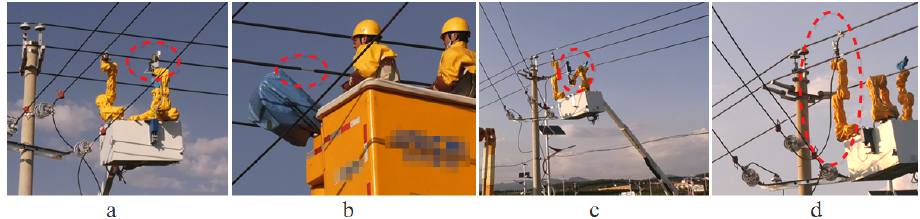
Figure 24. Field work: drainage operation on overhead lines. (( a ) wire stripping, ( b ) inspect stripping quality, ( c ) install the clamp, and ( d ) single-phase drainage operation is